Question: Looking at the figure, what chart type is it?
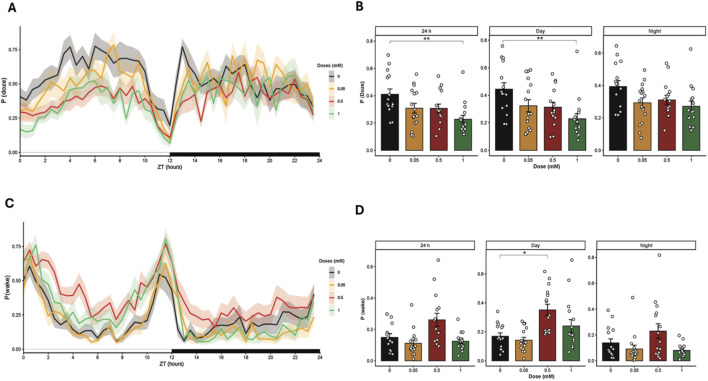
Answer: bar